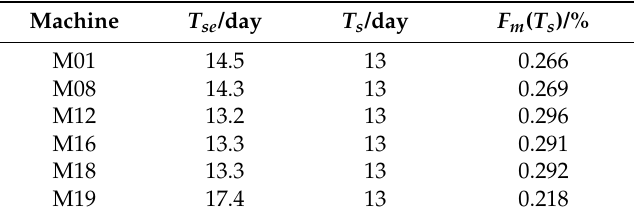
Table 5. The cumulative failure probability of secondary critical machines.